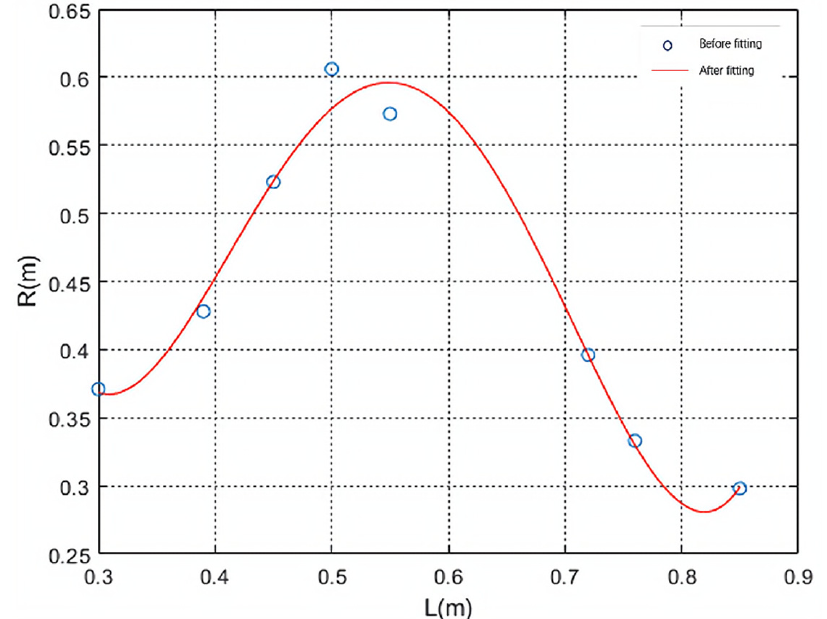
Figure 6. V-L blast funnel characteristic curve.